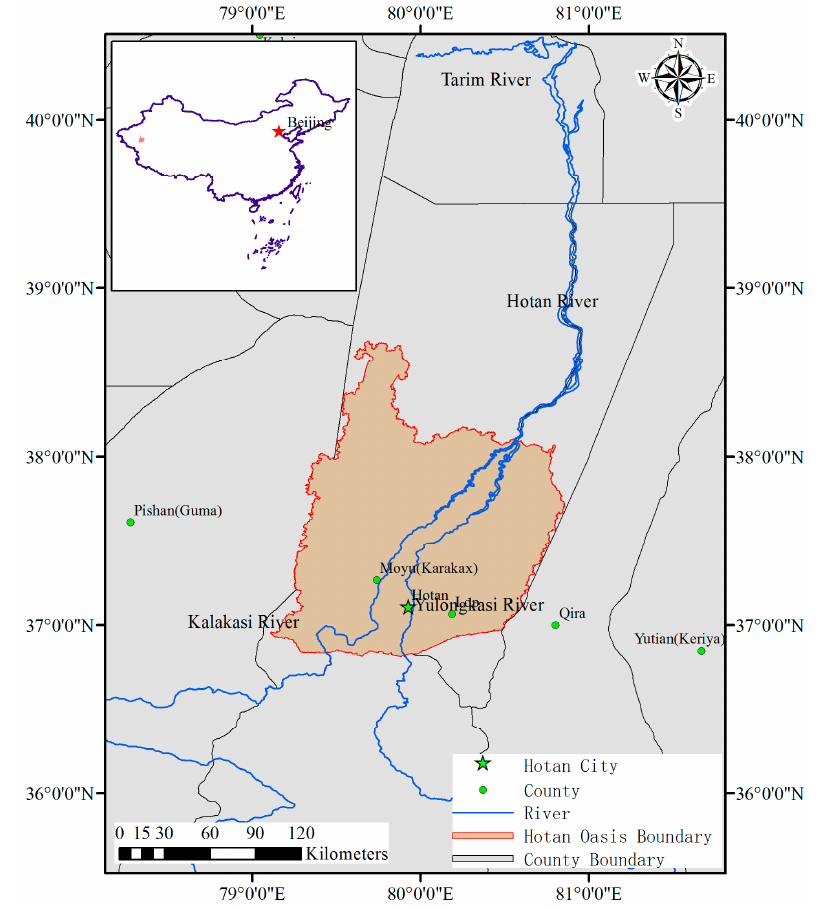
Figure 1. The study area location.